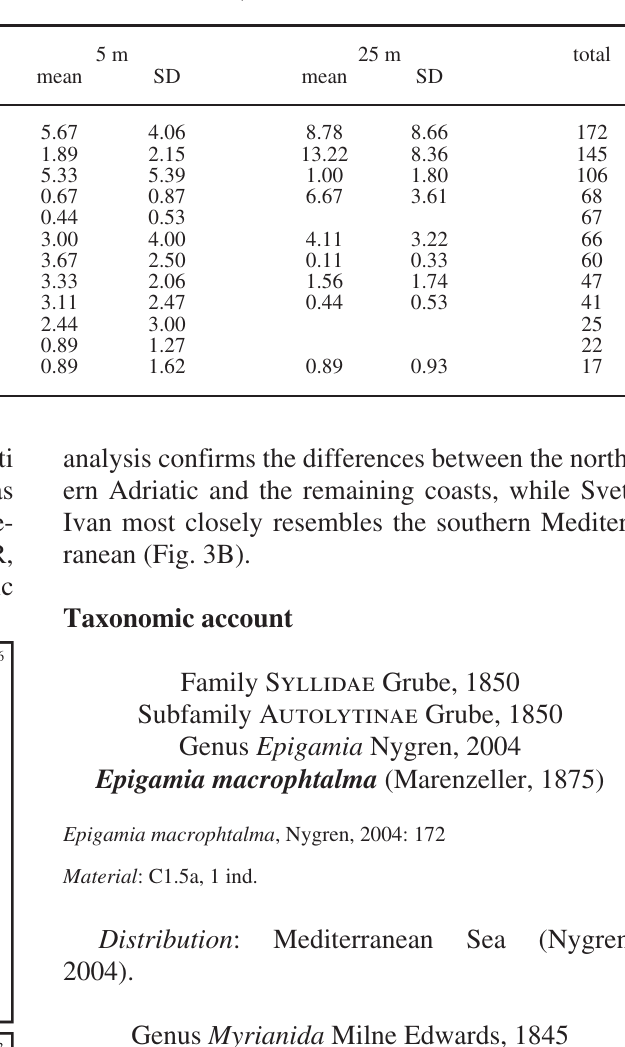
Table 3. – Mean number of individuals (mean) per sampling unit (0.01 m 2 ) plus standard deviation (SD) of the 12 most abundant syllid spe- cies at 1.5, 5 and 25 m deep. Total: number of collected individuals; *: new for the area